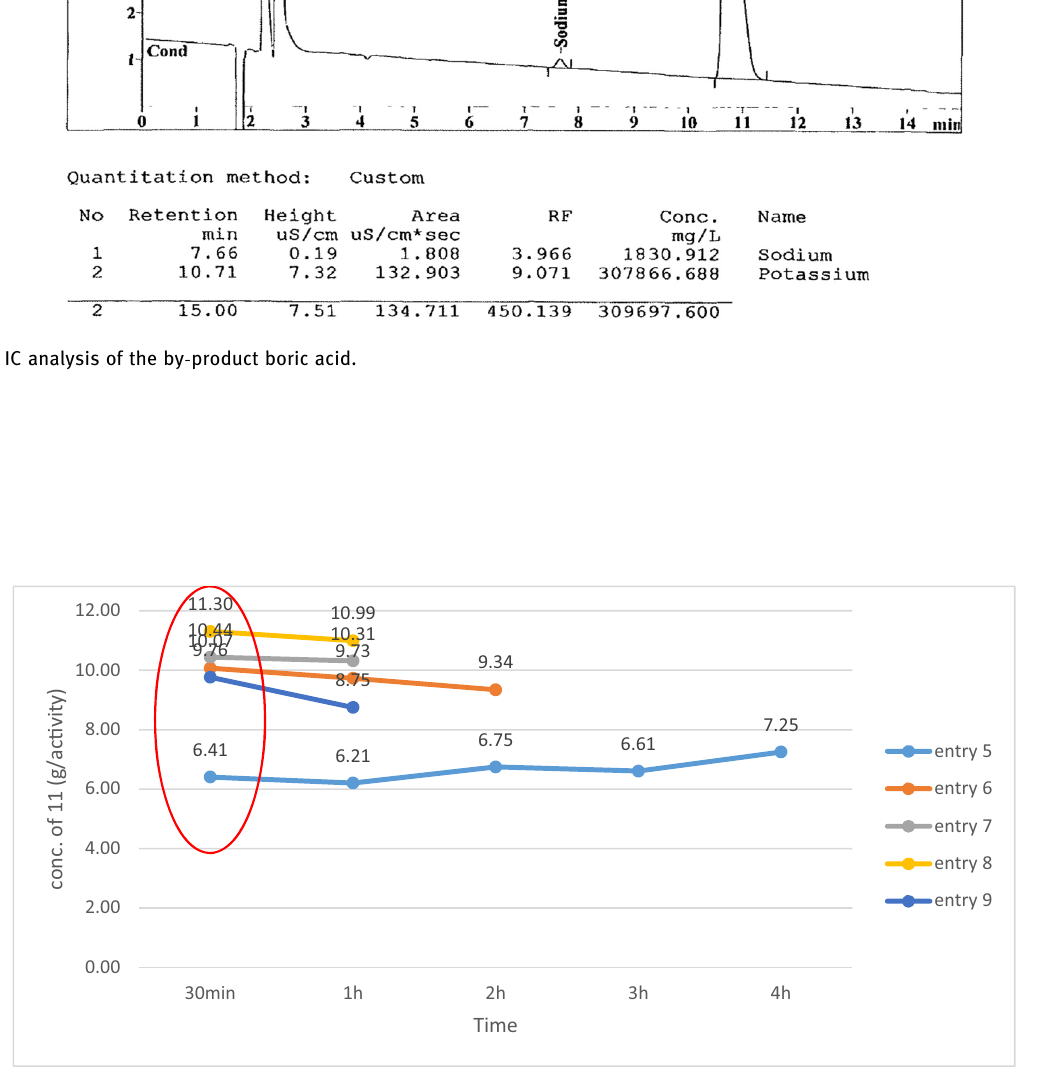
Figure A2: Kinetic assessment of 11 in